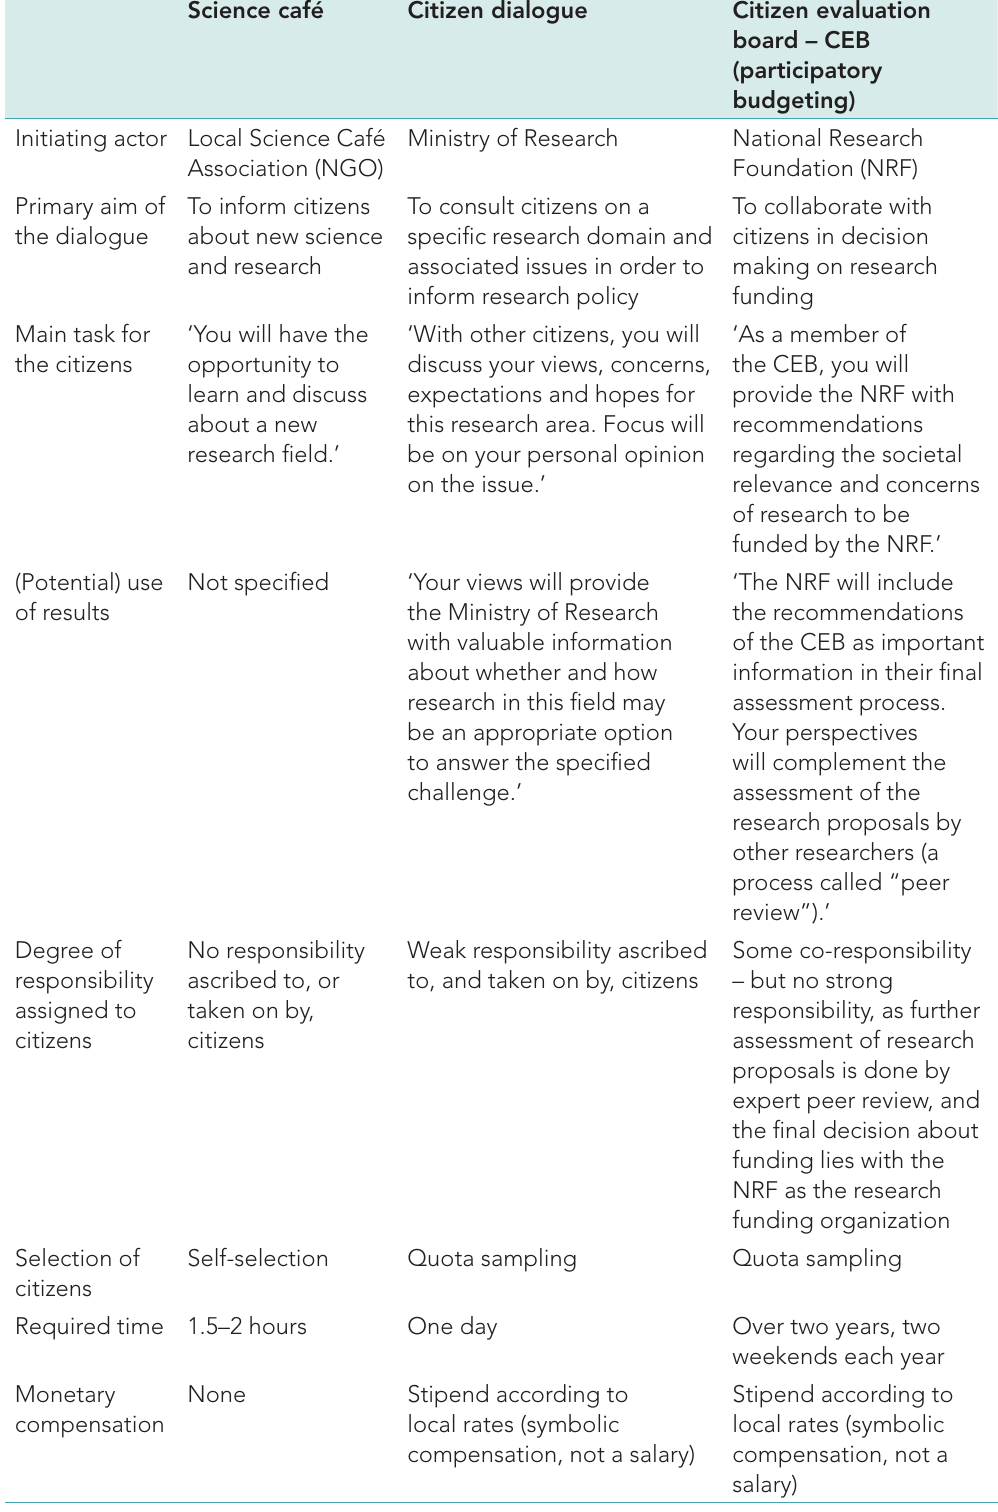
Table 1: overview of the three dialogue formats, as elaborated in the fictitious invitation letters (drawing on Kosow et al., 2016: